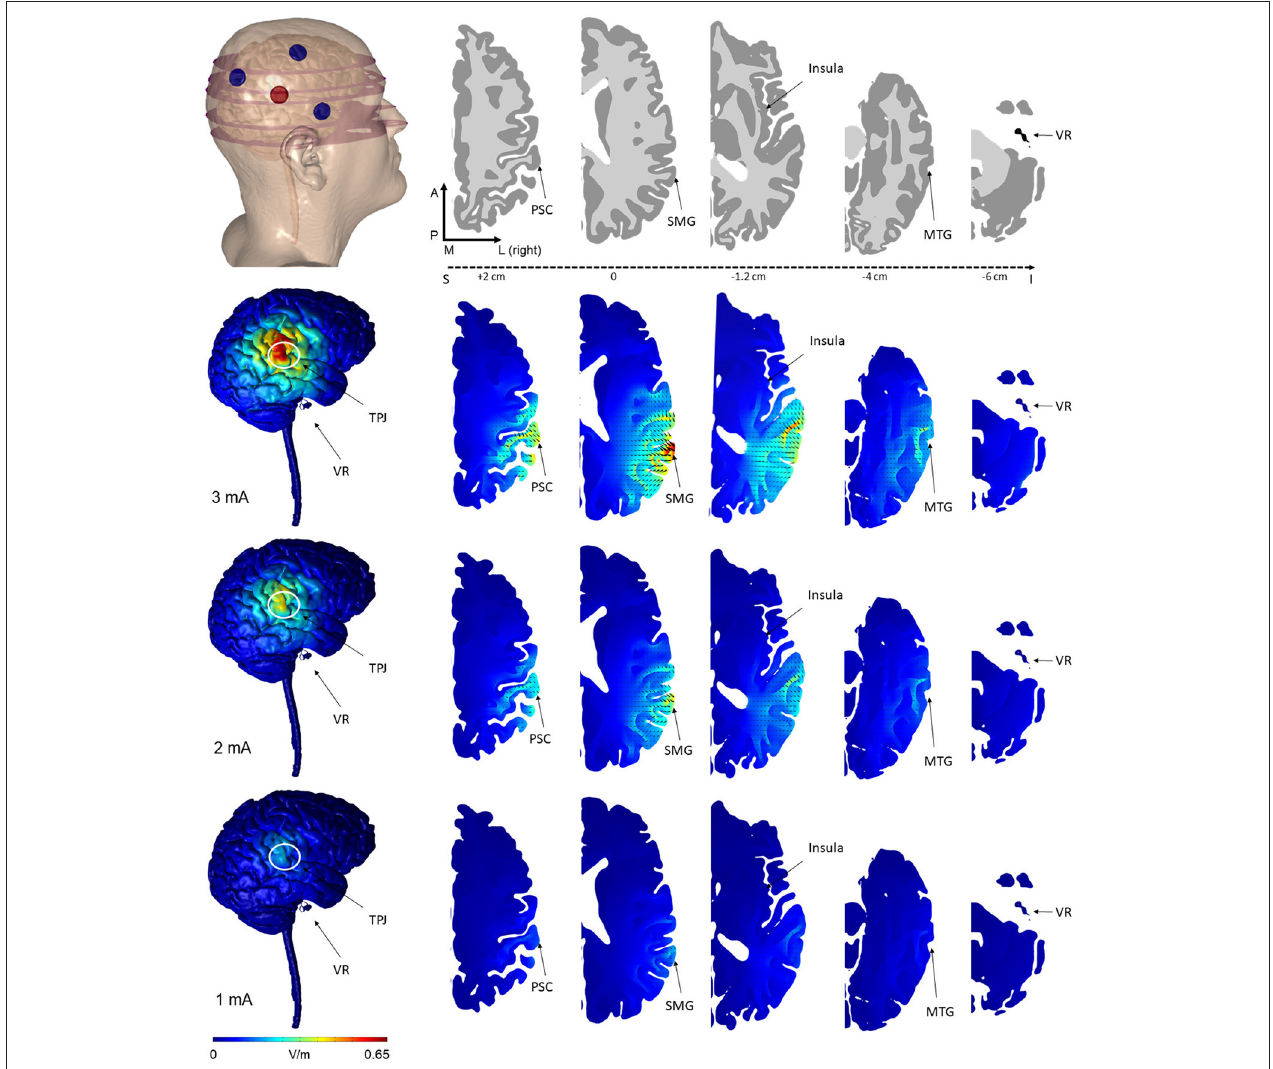
FIGURE 2 | Finite element models of tDCS using the novel 3 × 1 HD-tDCS electrode montage over TPJ predicted the induced electric field on the brain. The 3 cathode − 1 anode (or conversely 3 anode − 1 cathode) montage produced peak electric field concentrated under the center electrode at the TPJ. While the relative spatial distribution is unchanged between stimulation intensities, electric field magnitude increases linearly from 1 to 3mA. Note that for all montages, little electric field is induced at the vestibular apparatus. Electric field magnitude at the TPJ and other regions of interest were predicted at 3 intensities (Rows: 3, 2, 1mA) and plotted on the same scale for comparison. Current density direction within each slice, analogous to stimulation polarity, was predicted as cones directed into the cortical surface for anode-center stimulation. The model geometry (slice location within the head, electrode position, and neuroanatomy) are illustrated in the top row (VR, vestibular receptors; TPJ, Temporo-Parietal Junction; PSC, Primary Somatosensory Cortex; SMG, Supramarginal Gyrus; MTG, Middle Temporal